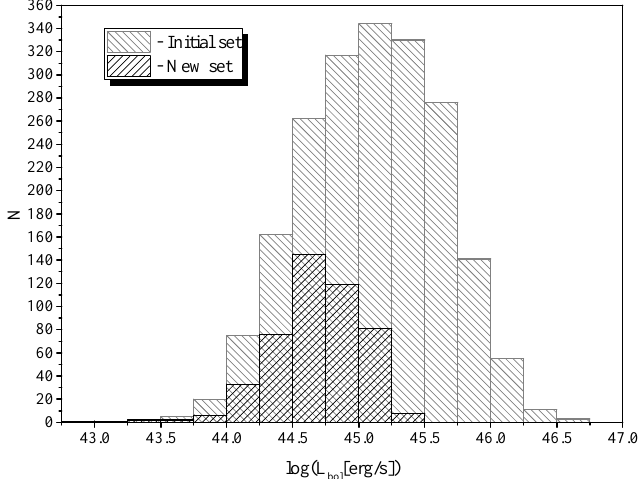
Figure 5. The distribution of the bolometric luminosity for the initial and new